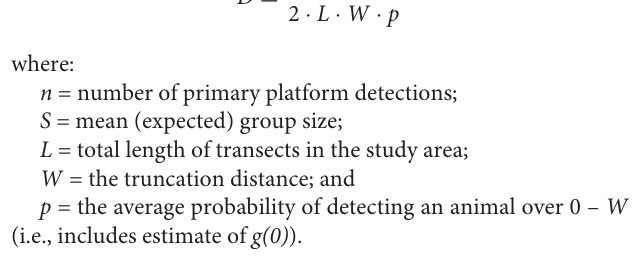
The detection function was conditional for the primary platform (PP) given detection by the tracker platform (TP). PP p and PP g(0) denote the probability of detection averaged over the truncation distance and on the transect line,